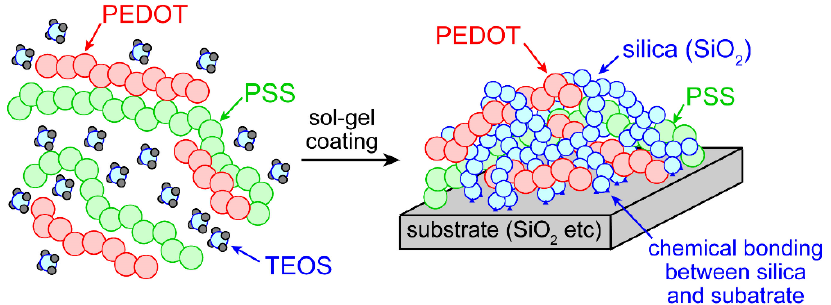
Figure 12. Synthesis of the PEDOT:PSS/silica composite using sol–gel reaction.